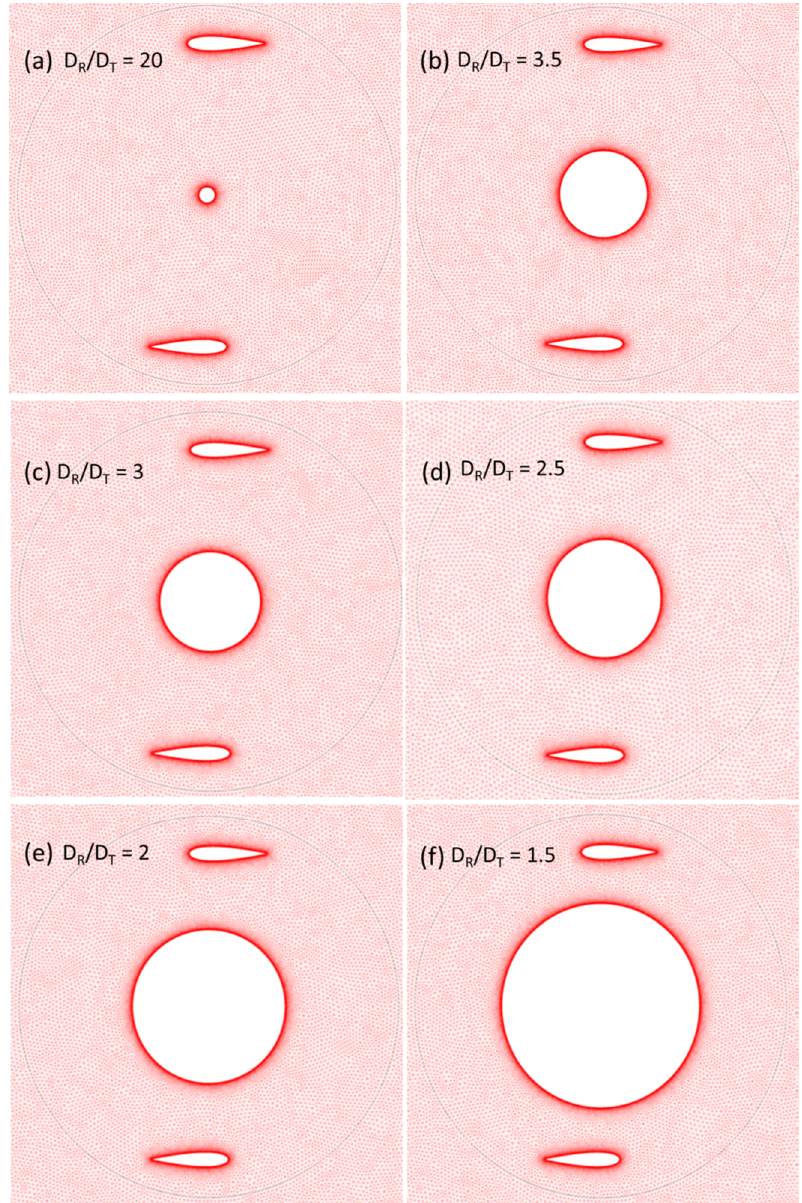
Figure 3. Mesh display for various diametrical ratios.